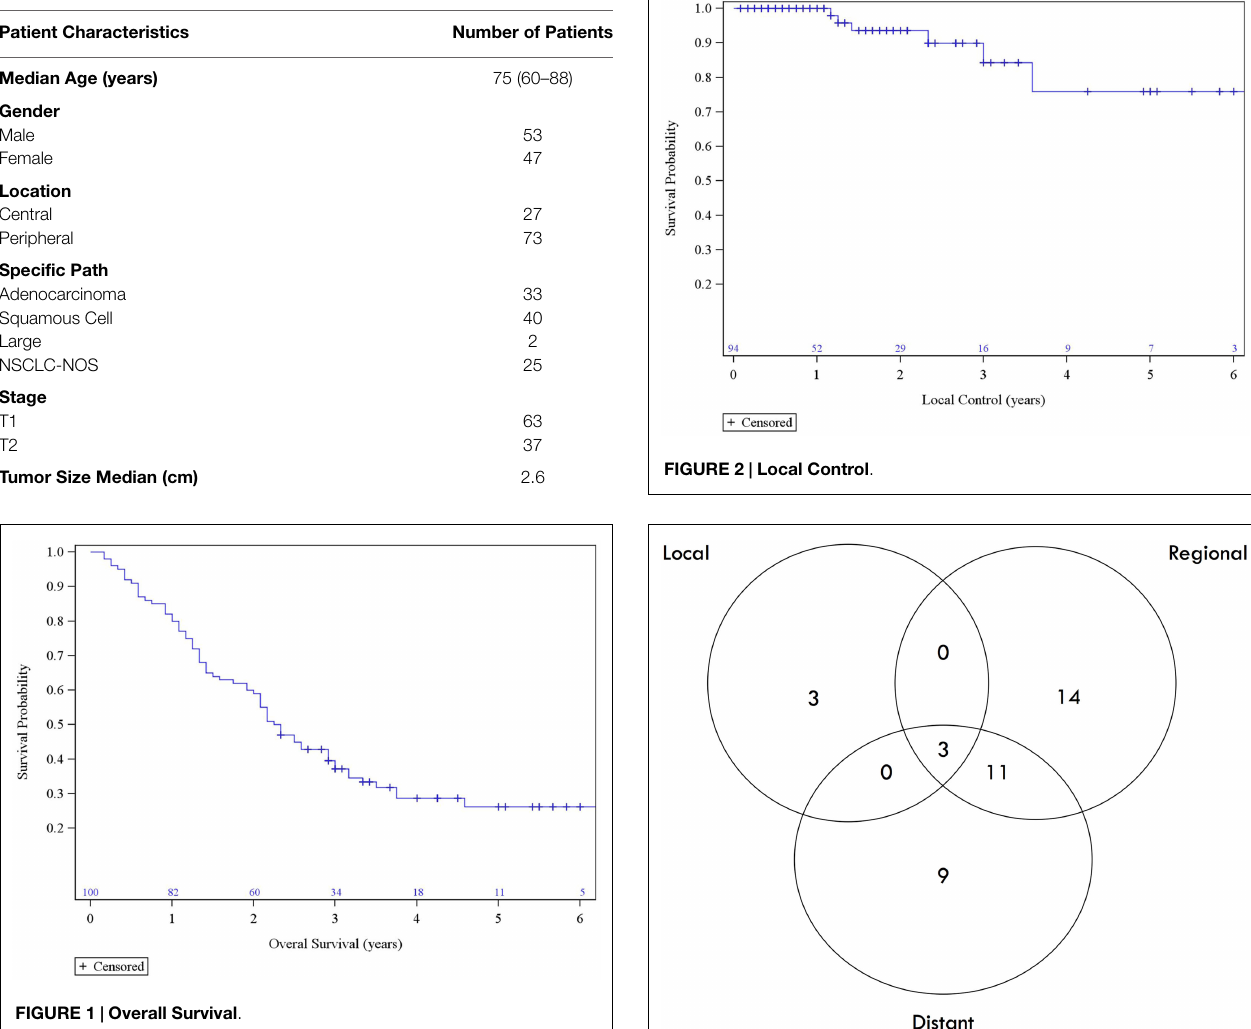
TABLE 1 | Patient Characteristics .